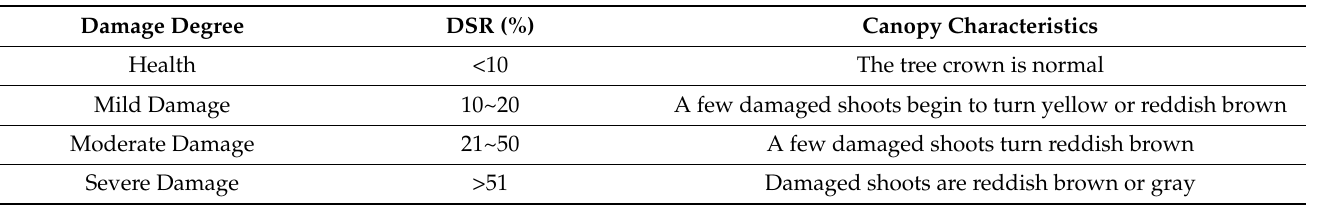
Table 1. Damage degree of Pinus yunnanensis (Franch.) by Tomicus spp. and the canopy characteristics.